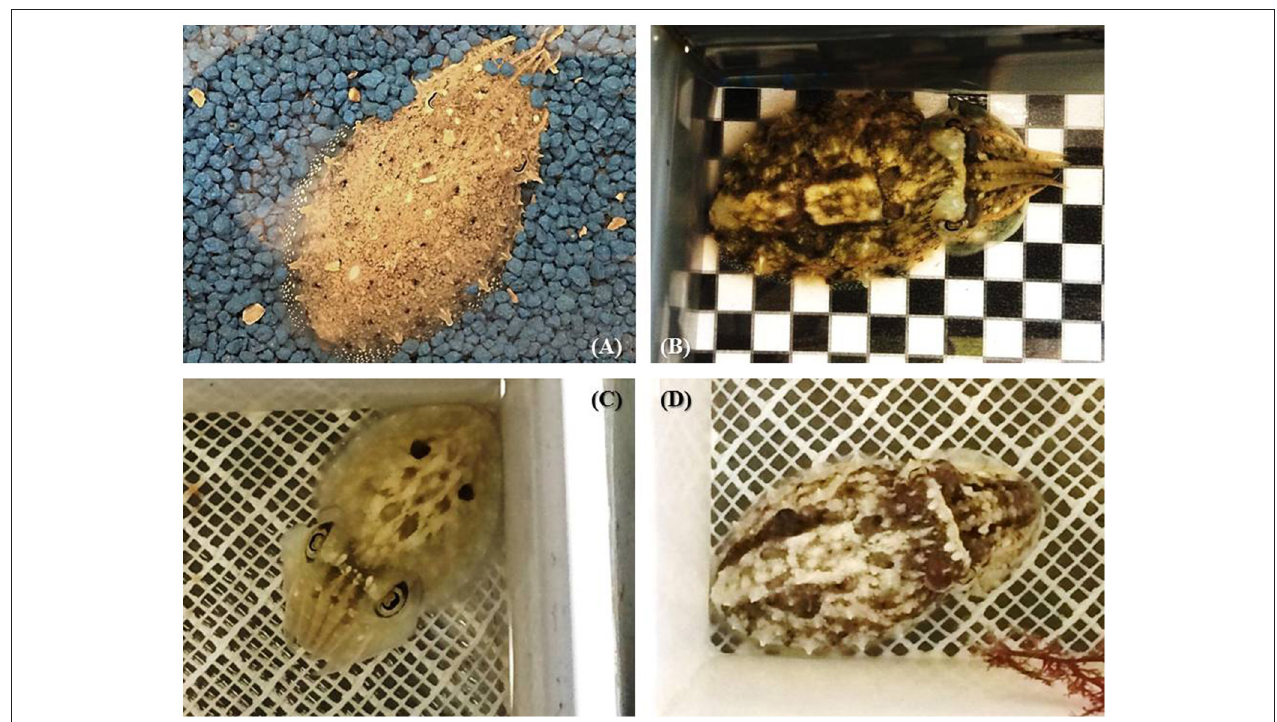
FIGURE 5 | The diversity of body patterns displayed by 2-month-old cuttlefish (ca. 3–4 cm dorsal mantle length). (A) stipple-uniform pattern elicited on uniform blue gravel; (B) disruptive pattern elicited on a black and white checkerboard combined with mottle pattern; (C) deimatic pattern following exposure to a “threat” (D) mottle coloration with some components of the disruptive pattern (i.e., white square, white head bar, and paired black dots). Note that patterns are not always fully expressed but exist in combination with others and may or may not directly reflect the visual